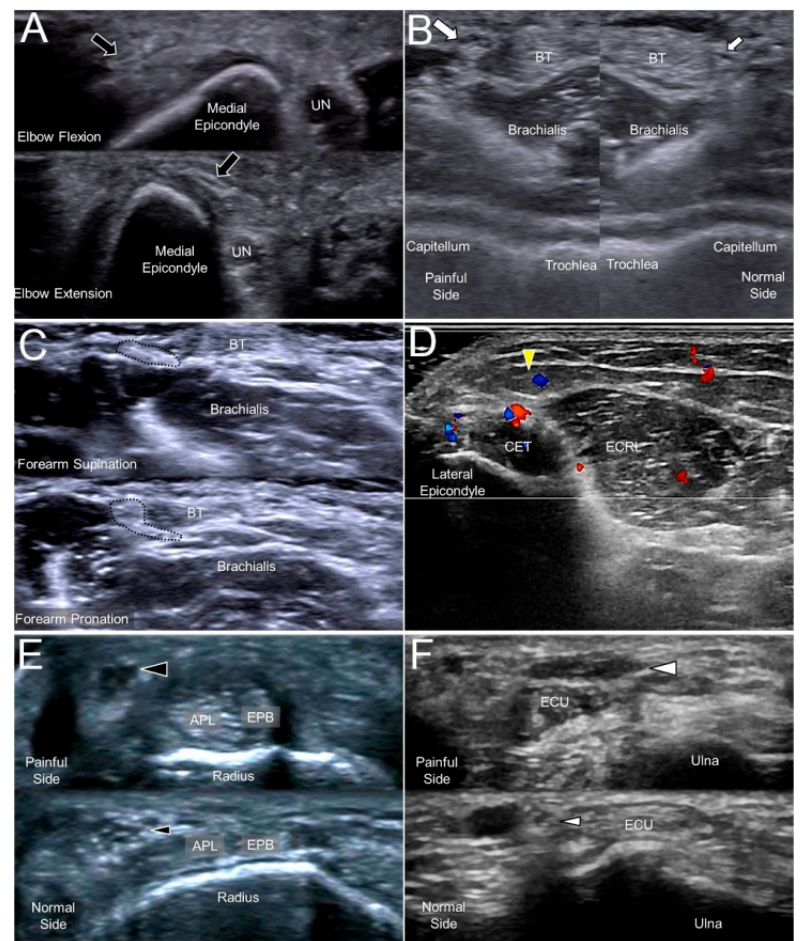
Figure 3. A snapped medial antebrachial cutaneous nerve (black arrow) in a woman complaining of forearm pain ( A ). A swollen lateral antebrachial cutaneous nerve (big white arrow) compared to the nerve of the asymptomatic side (small white arrow) in a woman with forearm pain ( B ). A lateral antebrachial cutaneous nerve (dotted circle) entrapped by the distal biceps tendon during elbow supination/pronation ( C ). A posterior antebrachial cutaneous nerve (yellow arrowhead) with peripheral hypervascularity in a male with chronic lateral epicondylitis ( D ). A swollen superficial radial nerve (big black arrowhead) compared to the nerve on the asymptomatic side (small black arrowhead) in a man with de Quervain’s tenosynovitis ( E ). A neuroma of the dorsal ulnar cutaneous nerve (big white arrowhead) and the normal contralateral nerve (small white arrowhead) in a man with a fracture of the 5th metacarpal bone ( F ). UN, ulnar nerve; BT, biceps tendon; CET, common extensor tendon of the wrist; ECRL, extensor carpi radialis longus muscle; APL, abductor pollicis longus tendon; EPB, extensor pollicis brevis tendon; ECU, extensor carpi ulnaris tendon .